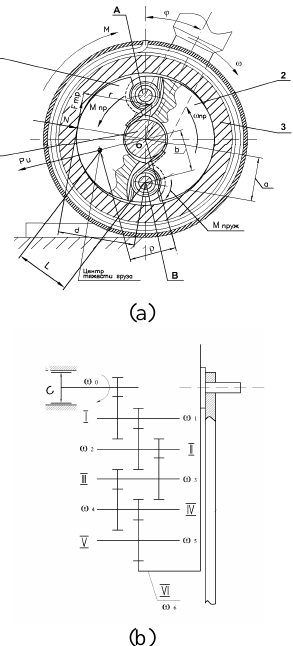
Fig.6. Centrifugal Brake of Rotation Mechanism.